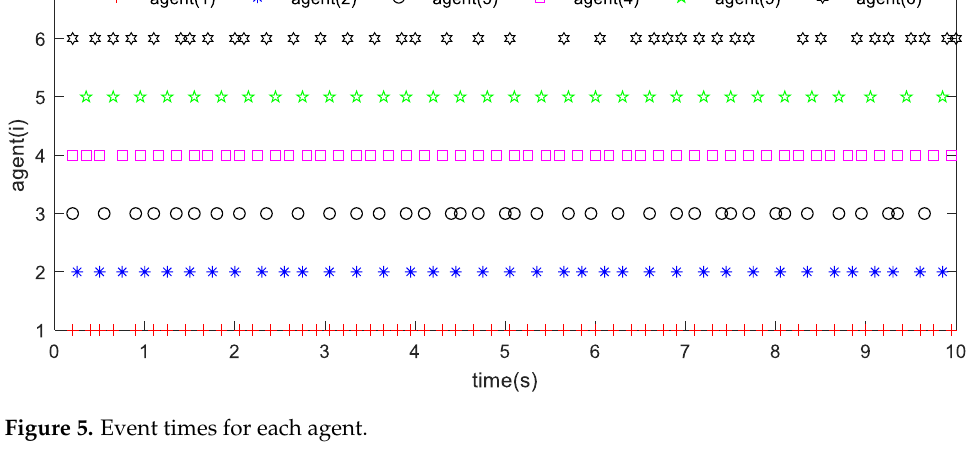
Figure 5. Event times for each agent.